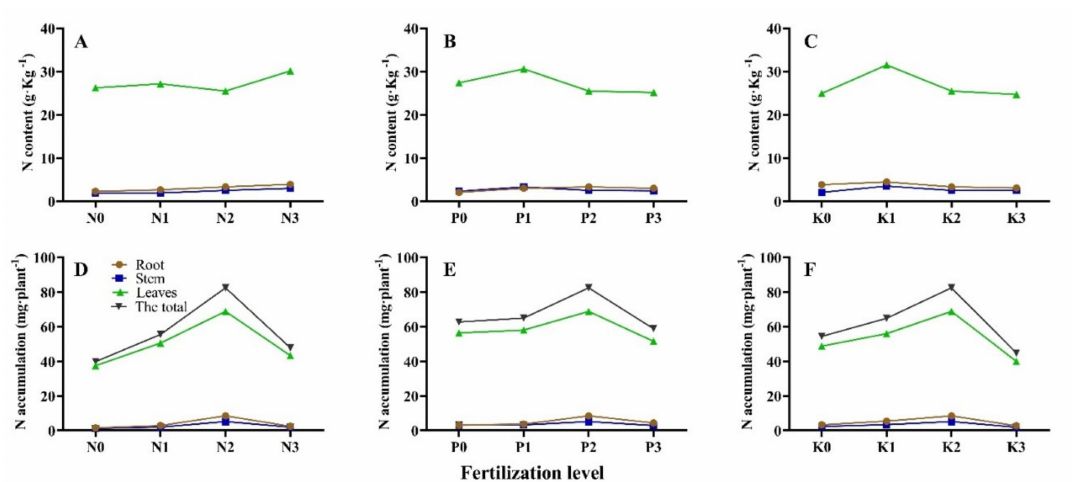
Figure 3. Changes of N content and accumulation in P. bournei seedlings under the single-factor N, P, and K fertilizer. ( A , D ): the single-factor of N fertilizer; ( B , E ): the single-factor of P fertilizer; ( C , F ): the single-factor of K fertilizer. Table 5. P content and accumulation of P. bournei seedlings under different N-P-K fertilization.